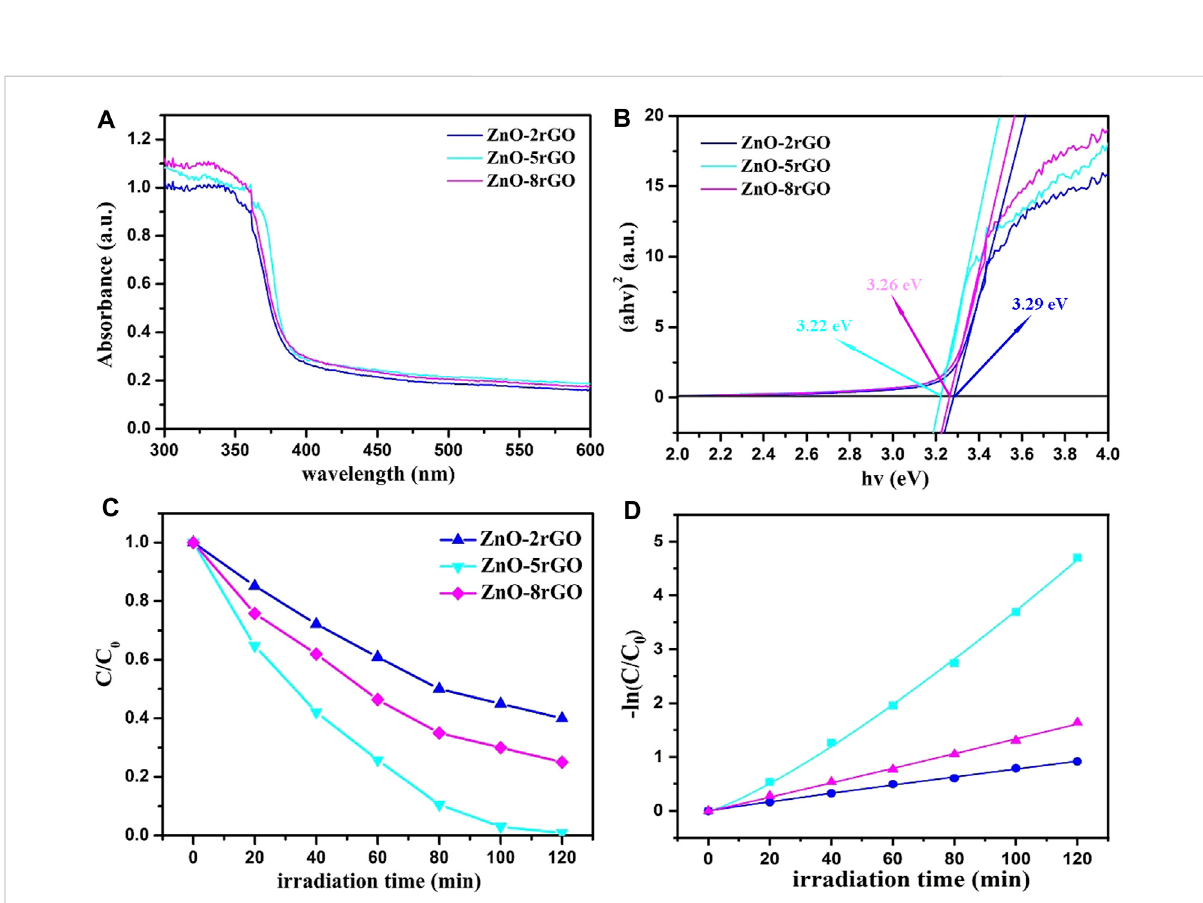
FIGURE 9 UV-vis absorption spectroscopy of ZnO-2rGO, ZnO-5rGO and ZnO-8rGO composite materials (A) and the corresponding curves of ( α hv ) 2 versus the hv (B) ; variation ratios of the concentrations of the MB degraded by different catalysts versus irradiation time (C) , and the corresponding kinetic curves (D)